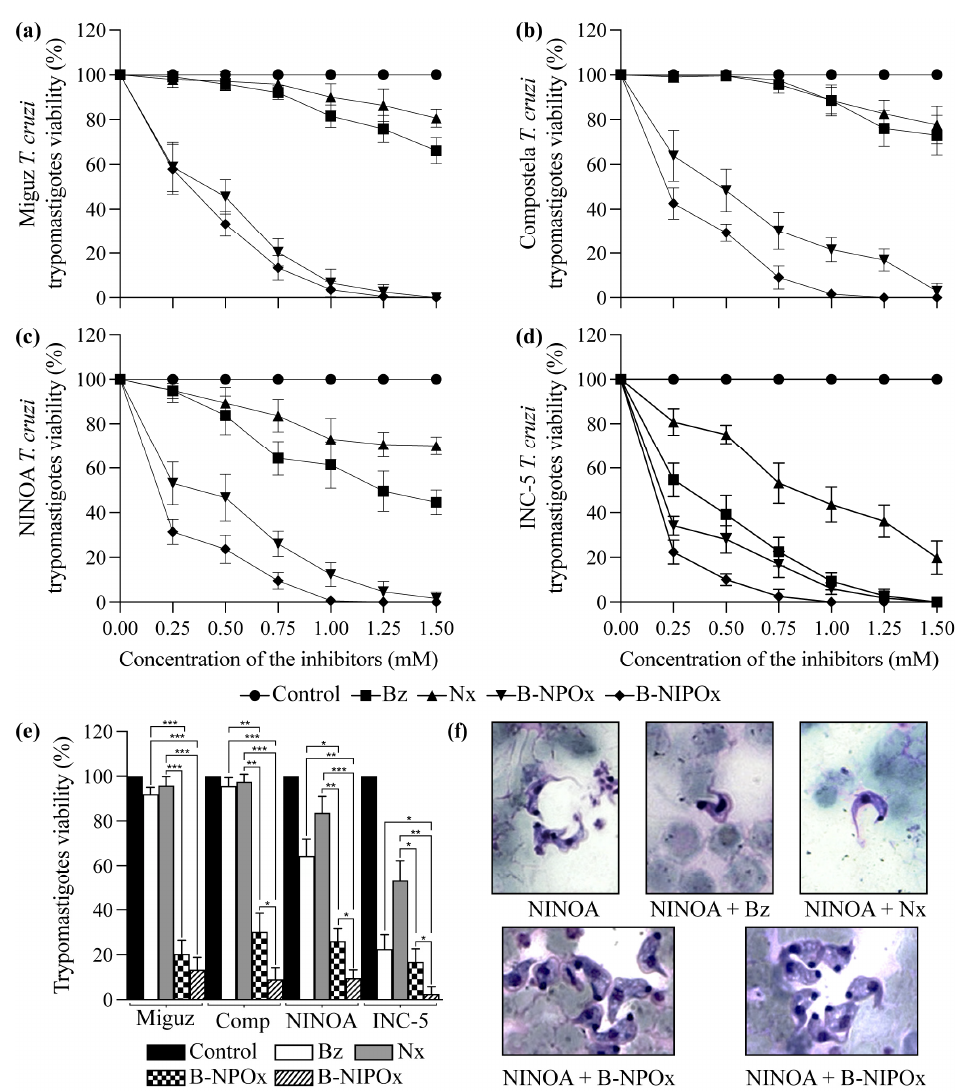
Figure 4. The benzyl ester of N-isopropyl oxamic acid (B-NIPOx) has higher trypanocidal activity on trypomastigotes than the benzyl ester of N-propyl oxamic acid (B-NPOx) and the reference drugs Benznidazole and Nifurtimox and alters the typical morphology of the parasite. The trypanocidal effect of B-NIPOx was evaluated on trypomastigotes of the ( a ) Miguz, ( b ) Compostela (Comp), ( c ) NINOA and ( d ) INC-5 T. cruzi strains, and compared with the drugs B-NPOx, Benznidazole (Bz) and Nifurtimox (Nx). The drugs were dissolved in 1% DMSO and were evaluated at concentrations of 0.25, 0.50, 0.75, 1.00, 1.25 and 1.50 mM for 24 h at 4 °C in cultures with 1 × 10 6 trypomastigotes/mL. The viability